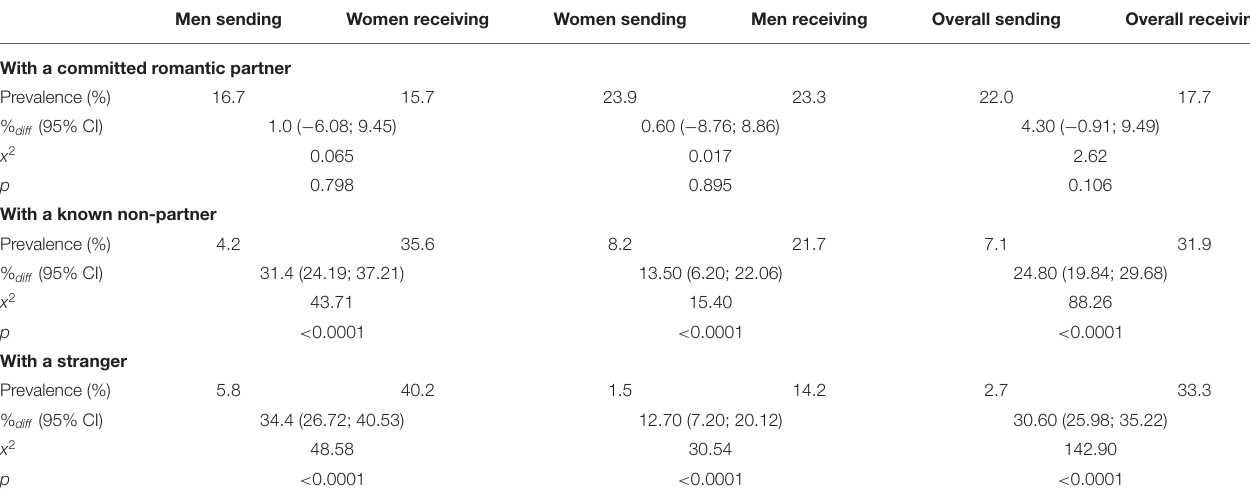
TABLE 5 | Prevalence of non-consensually sharing and having TMSIs non-consensually shared. Men shared Women had shared Women shared Men had shared Overall sharing Overall had shared With a committed romantic